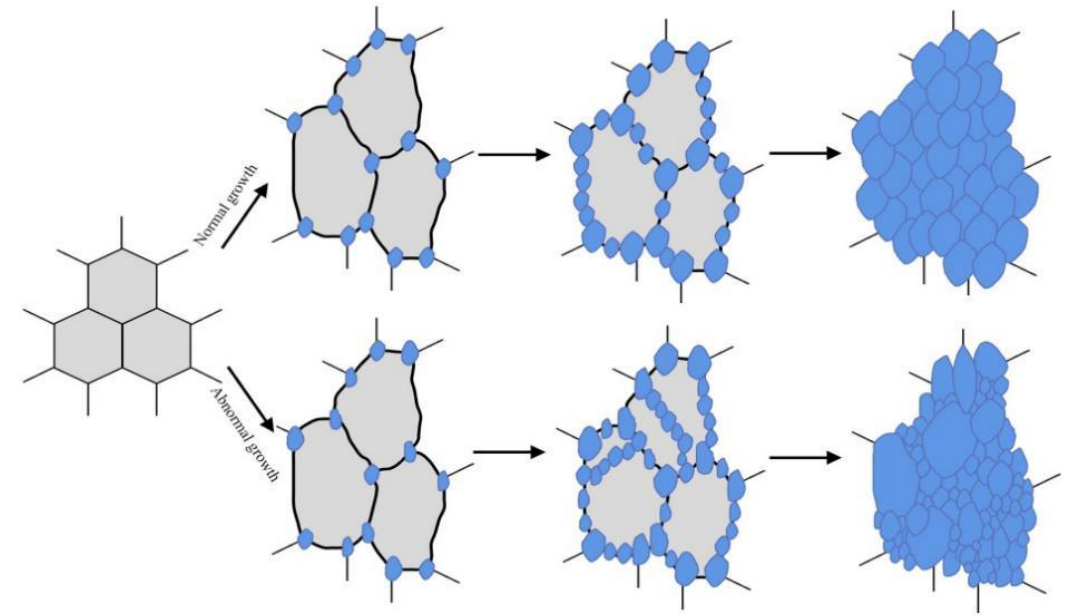
Figure 2. Schematic illustration of the DRX microstructures evolution of the RPV materials with the increase of strain [17,49].